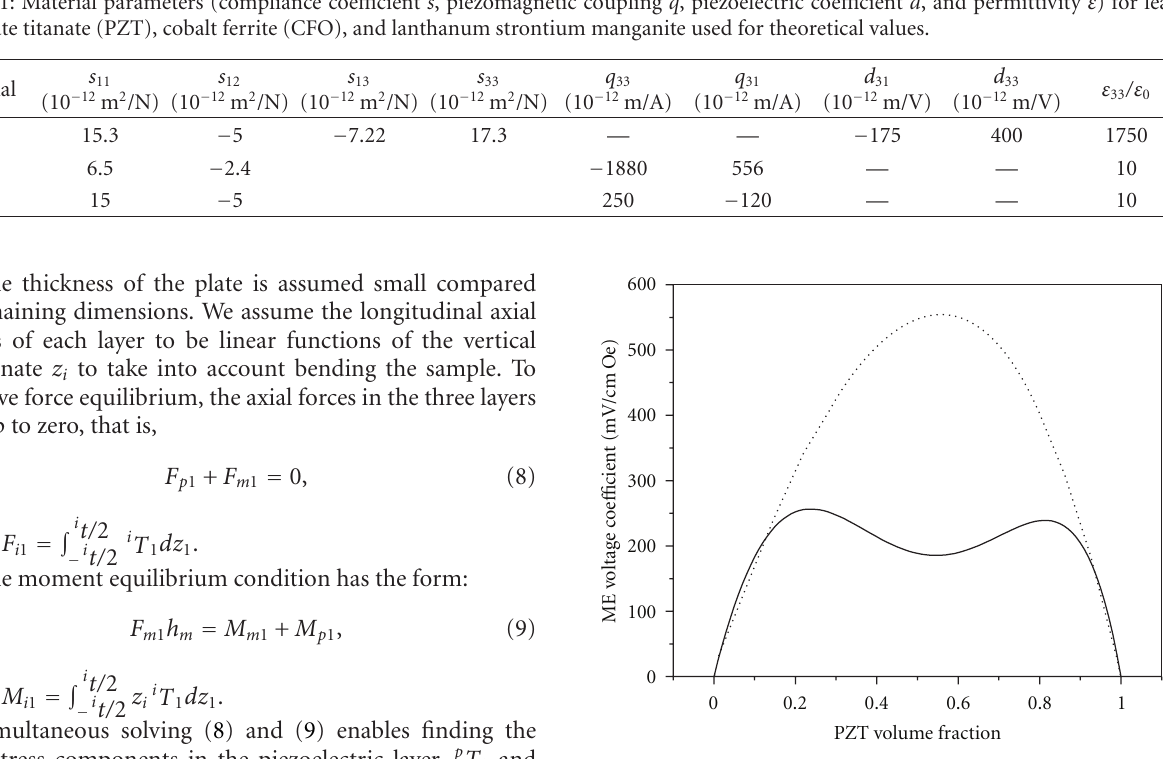
Figure 2: Transverse ME voltage coe ffi cient α E ,31 = δE 3 /δH 1 for a perfectly bonded ( k = 1) bilayer (solid line) and symmetric structure (dot line) of CFO and